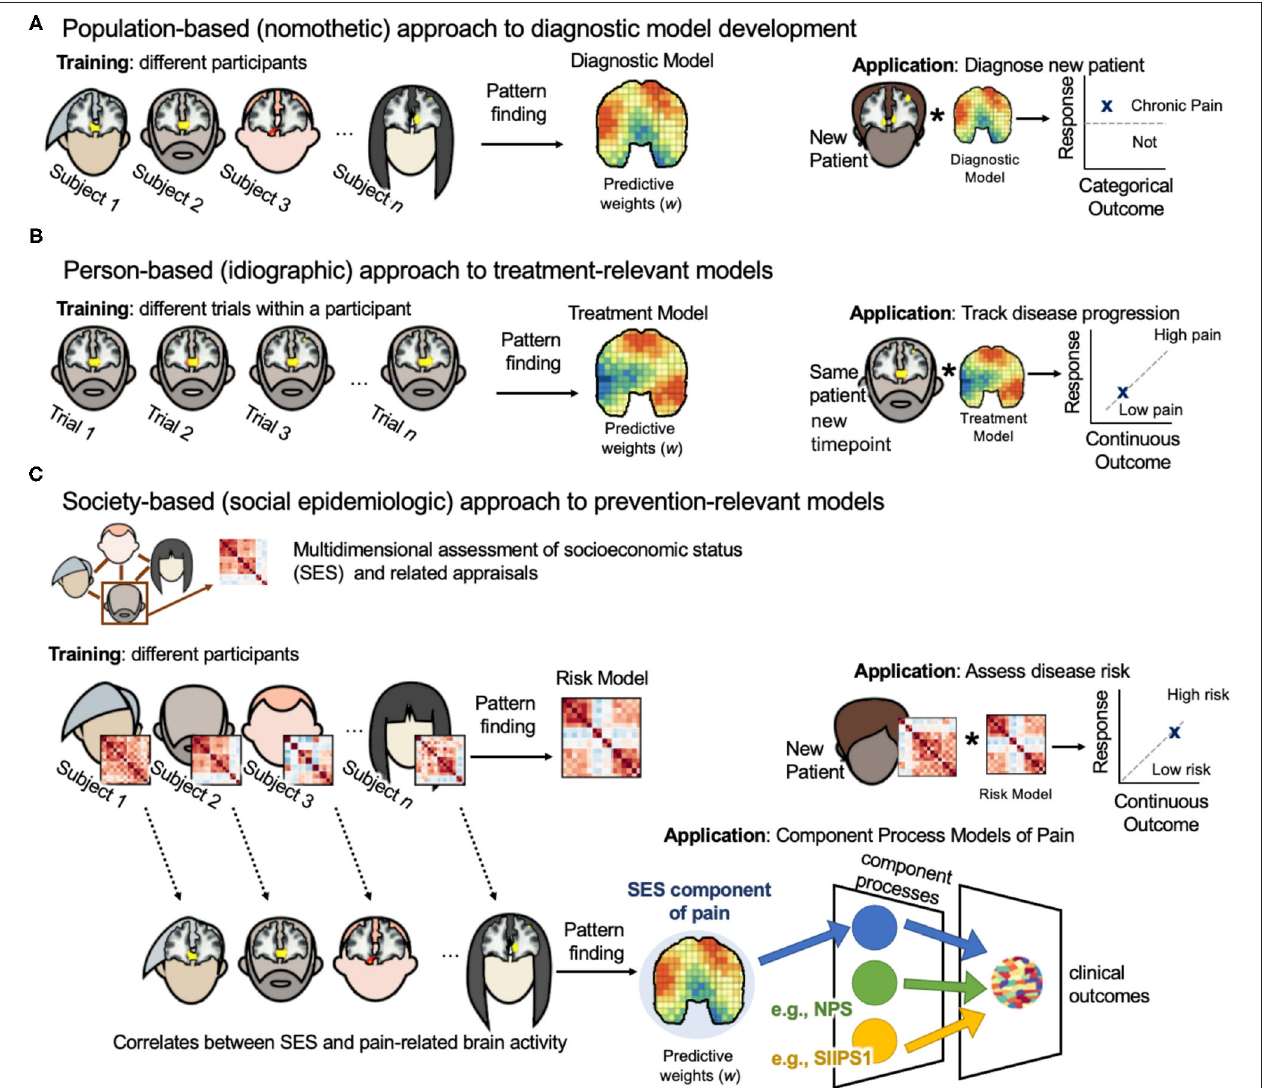
FIGURE 1 | Three-level biopsychosocial approach to neuroimaging biomarker development. (A) Population-based (nomothetic) approach to diagnostic model development. Neuroimaging model weights are estimates of population-level associations between brain activity and pain outcomes (i.e., diagnostic category vs. healthy control). Population samples should be large and diversely sampled across gender identity, race, and socioeconomic identities. Models should be validated on external clinical data sets. Models can then be applied to the brain activity of a new patient to diagnosis their pain condition. (B) Person-based (idiographic) approach to treatment-relevant models. Neuroimaging model weights are estimates of person-level associations between brain activity and pain outcomes (i.e., pain severity) for the same person through time. Models weights can be regulated by nomothetic models to lessen demands on data collection from one patient. Models can be applied in the same patient at later time points to assess their disease progression or to assess treatment efficacy. Such models can be used to tailor treatment selection on a case-by-case basis. (C) Society-based (social epidemiologic) approach to prevention-relevant models. This approach requires two steps. First, participants complete a multidimensional survey that assesses both their environment (i.e., socioeconomic status) and their personal internalization of these conditions ( Table 1 ). Then, a risk model is trained on these survey data to predict pain severity. The weights of this risk model are estimates of population-level associations between a person’s socioeconomic conditions and pain outcomes. This model can be applied to the survey data of a new patient to assess their risk of pain chronification. Person-level survey data can be related to person-level pain-related brain activity, and then a neuroimaging model of the SES component of pain processing can be developed. Neuroimaging model weights are estimates of group-level associations between the socioeconomic conditions a person lives in and their pain-related brain activity. Such a model could be combined with other neuroimaging component process models of pain, such as the NPS and SIIPS1, to predict clinical outcomes in new